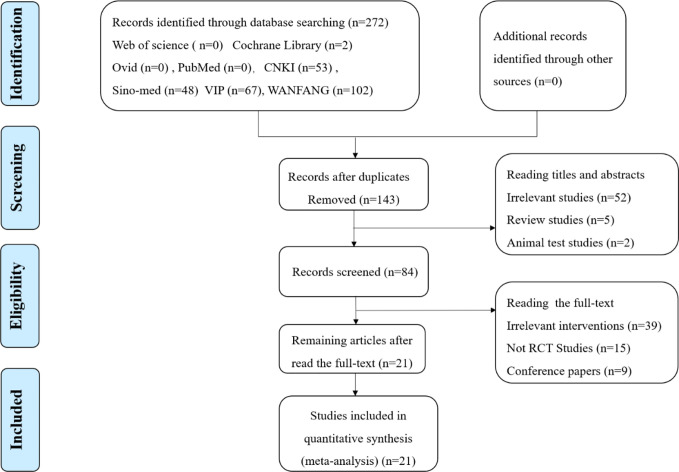
Flow chart of study selection.